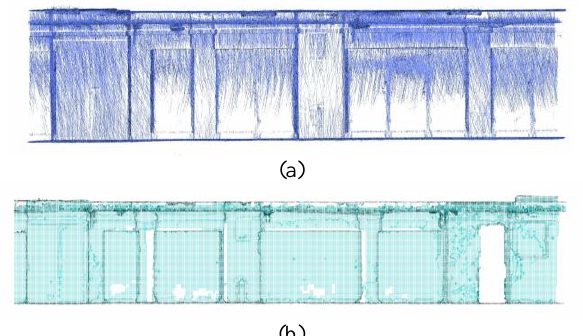
Figure 18. Point cloud of architectural details: (a) BLK2GO; (b)